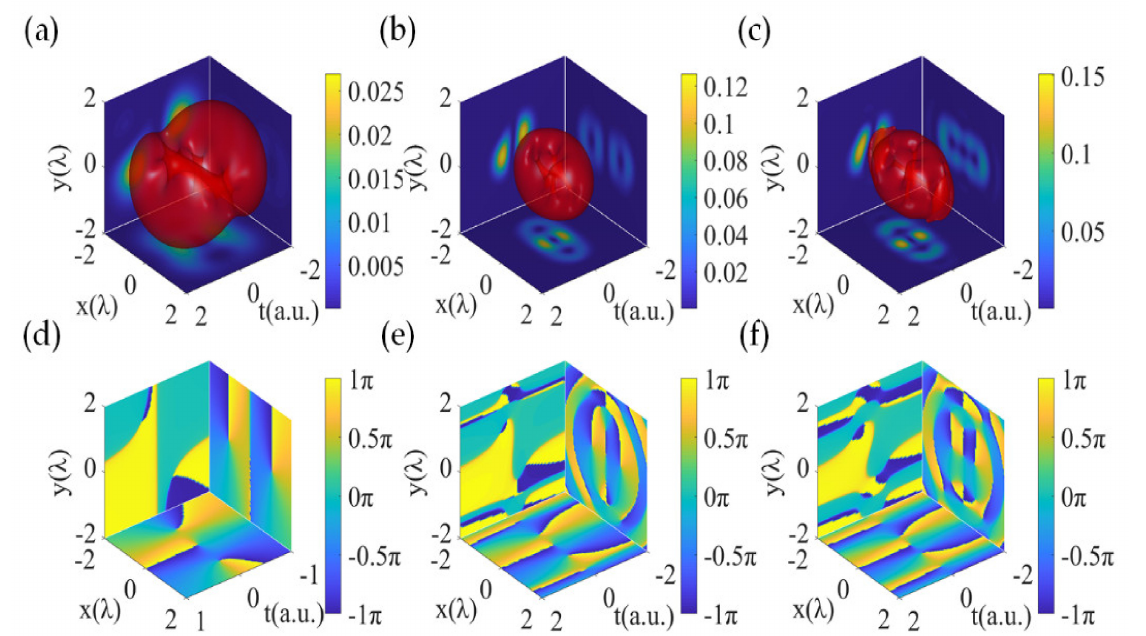
Figure 6. The intensity and phase distributions of the z-polarized components of the focused STOVs under different incident spatial waist radii. ( a – c ) The intensity distributions of the z-polarized components of the focused STOVs corresponding to incident spatial waist radii of 0.3, 0.5, and 0.7, respectively. ( d – f ) The phase distributions corresponding to the three cases, respectively. The isosurfaces are depicted at 3% of the maximum intensity in each case.